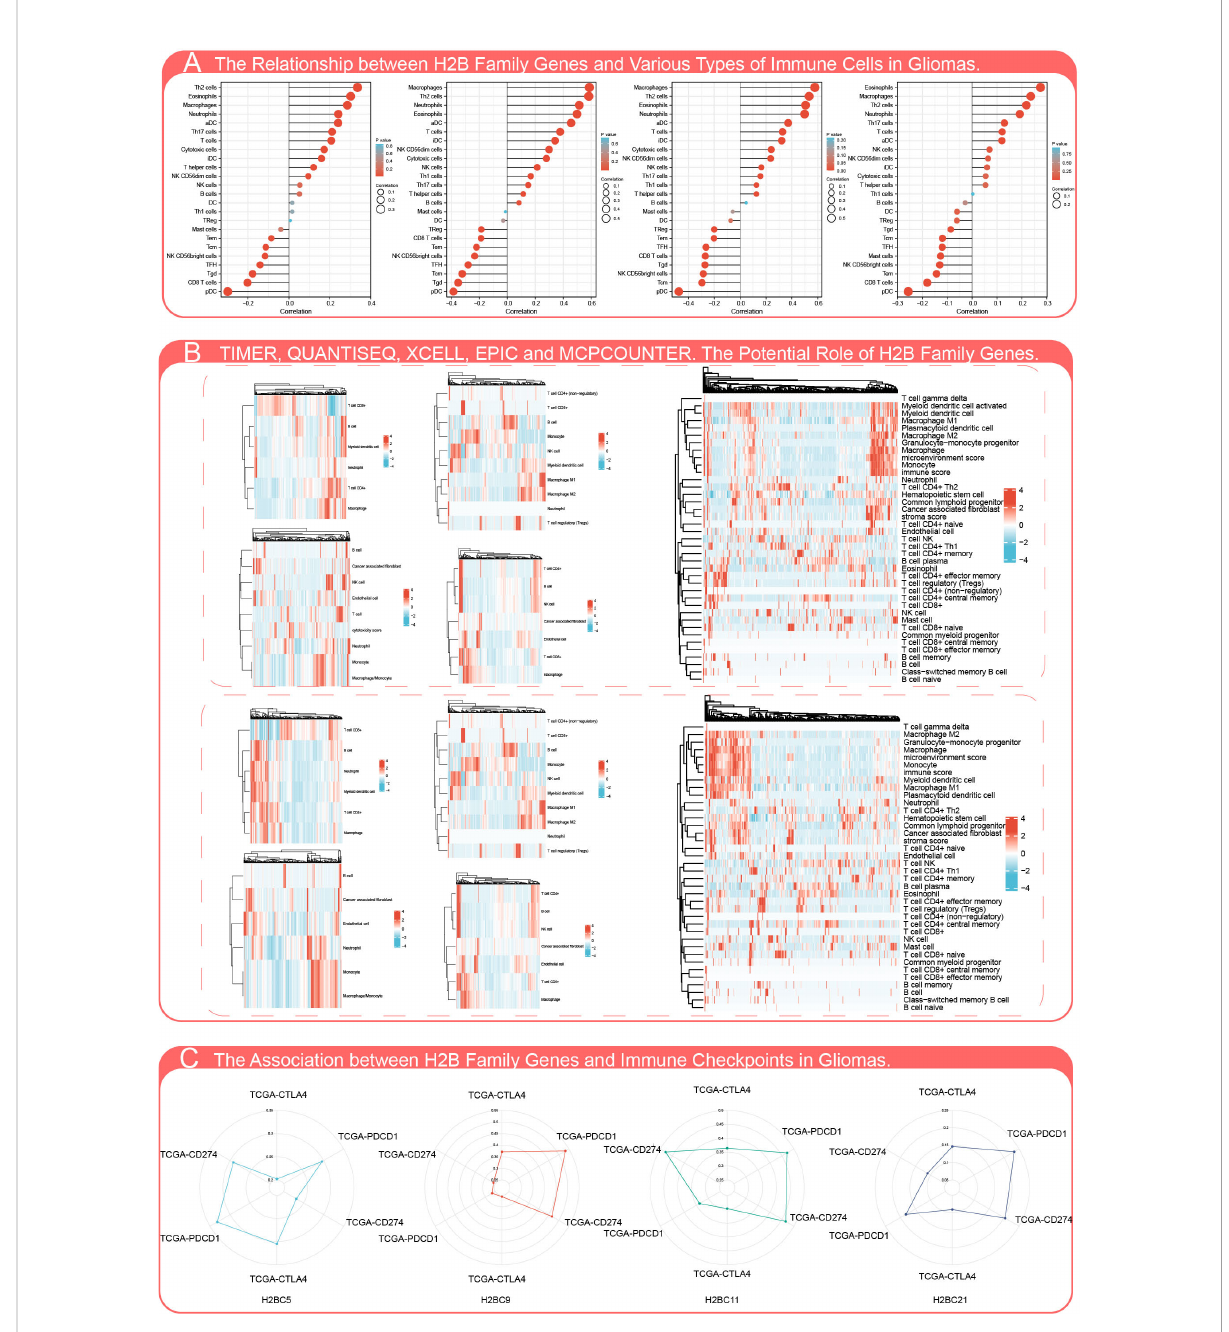
FIGURE 6 In fl uence of H2B gene expression on immune cell in fi ltration. (A) Correlation analysis of H2BC5, H2BC9, H2BC11, and H2BC21 (from left to right) gene expression and in fi ltration of various types of immune cells. (B) Timer, QUANTISEQ, XCELL, EPIC, MPCOUNTER algorithms were used to analyze the correlation between H2B gene expression and immune cell in fi ltration in low-grade (top) and malignant glioma (bottom). (C) Correlation analysis of H2BC5, H2BC9, H2BC11, and H2BC21 gene expression and the immune checkpoint biomarkers, CTLA4, PDCD1, and